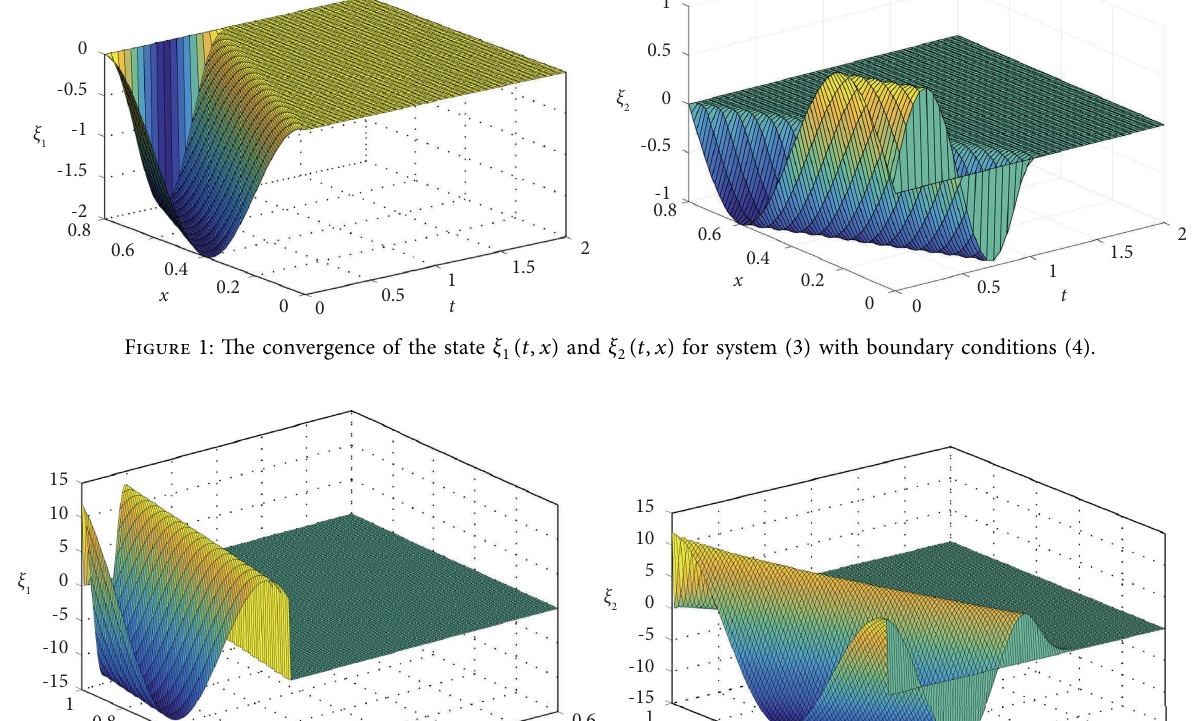
( t,x ) and ξ ( t,x ) for system (33). 1 2